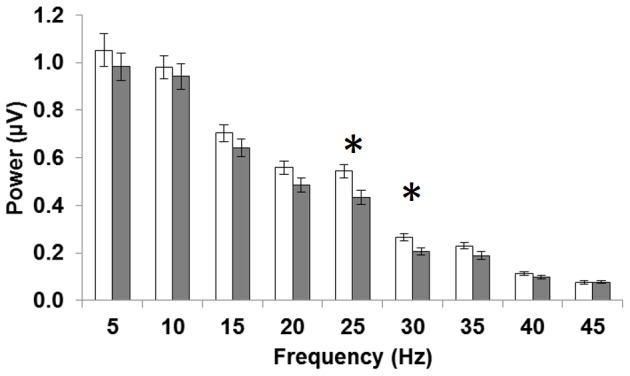
Group average frequency-domain power spectrums.The mean focal cone ERG signal for all control (White) and early AMD (Grey) participants are shown in the frequency-domain (power spectrum) at the fundamental frequency (f0 = 5 Hz) and its harmonics up to 45 Hz. Error bars show standard error whilst stars (*) denote statistical difference between groups at the p = 0.05 significance level.